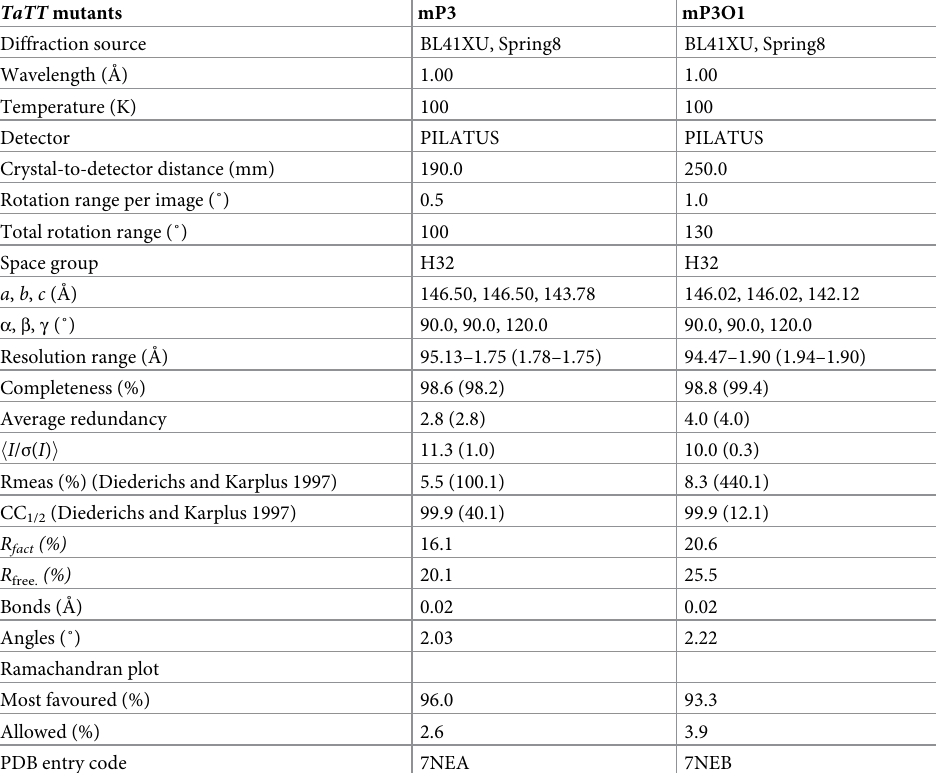
Table 1. Data collection, processing, and